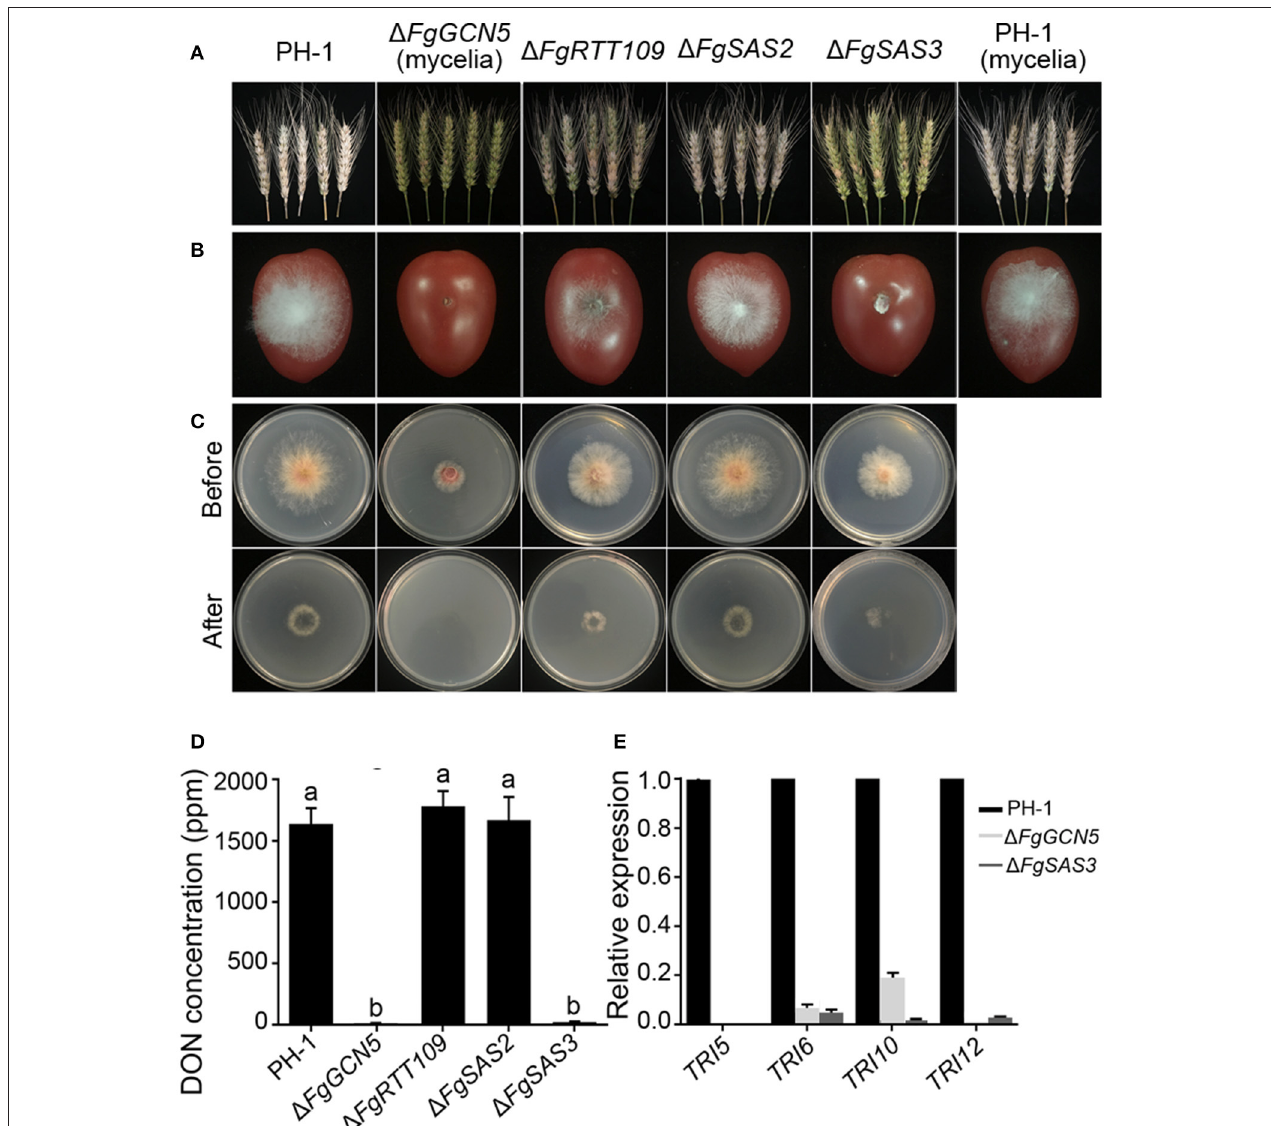
FIGURE 4 | Comparison of virulence, DON production and the relative expression levels of selected trichothecene genes in PH-1 and the deletion mutants. (A) Pathogenicity on flowering wheat heads. Flowering wheat heads were point inoculated with a conidial suspension at 10 6 conidia/mL of the wild type strain PH-1, 1 FgRTT109 , 1 FgSAS2, and 1 FgSAS3 . In the case of 1 FgGCN5 , a mycelial suspension was used to inoculate wheat ears. Infected wheat heads were photographed 2 weeks after inoculation. (B) Pathogenicity on cherry tomato fruits. Cherry tomatoes were inoculated with a conidial suspension at 10 6 conidia/mL of PH-1, 1 FgRTT109 , 1 FgSAS2, and 1 FgSAS3 . A mycelial suspension of 1 FgGCN5 was inoculated into cherry tomatoes. Fruits were photographed 3 days after inoculation. (C) Penetration of PH-1 and four deletion mutants through cellophane membrane. Fungal colonies were grown for 2 d at 25 ◦ C on top of a cellophane membrane placed on minimal medium (MM) and were photographed (Before). The cellophane membranes with the fungal colonies were removed, and the plates were incubated an additional 24h to examine the presence of mycelial growth on the plates (After). (D) DON production by 1 FgGCN5 , 1 FgRTT109 , 1 FgSAS2, and 1 FgSAS3 mutants compared with the wild type. The amounts of DON produced by each strain were determined after 7 days of inoculation into TBI liquid medium. Line bars in each column denote standard errors of three replicated experiments. Values on the bars followed by the same letter are not significantly different at P = 0.05. (E) Relative expression levels of TRI5 , TRI6 , TRI10, and TRI12 in the wild-type PH-1, 1 FgSAS3 and 1 FgGCN5 assayed by qRT-PCR. The relative expression levels of TRI genes in 1 FgSAS3 and 1 FgGCN5 are the relative amounts of cDNA of the gene in the wild-type progenitor. Line bars in each column denote standard errors of three repeated